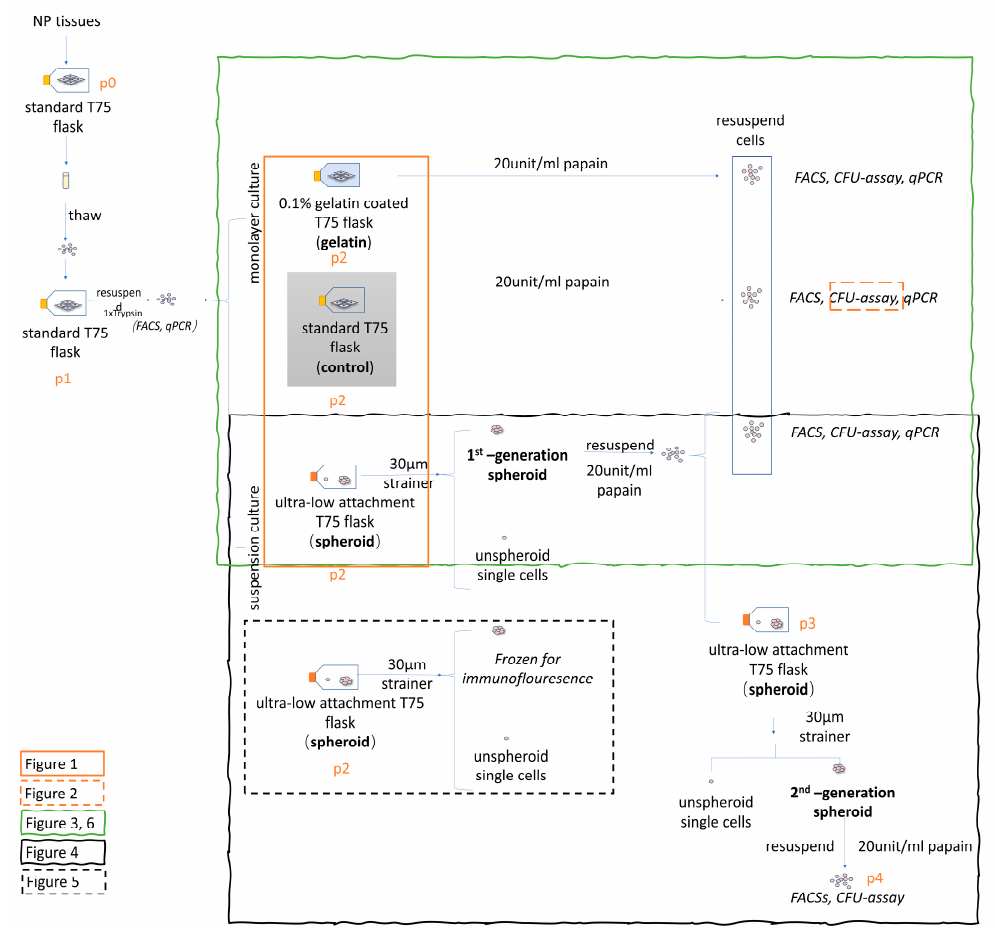
Figure 7. Flow graph of experimental design, important steps are outlined in bold. Figure legend: “p” represents passage.